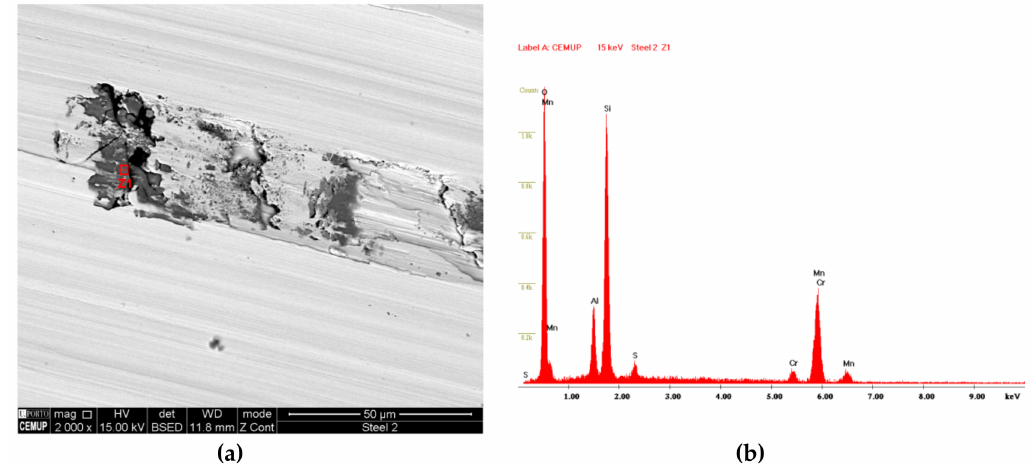
Figure 15. SEM images of small fragments retained in the chips. ( a ) SEM image of the hard fragment of the tool coating encased in the chip; ( b ) EDS confirmation of the fragment chemical